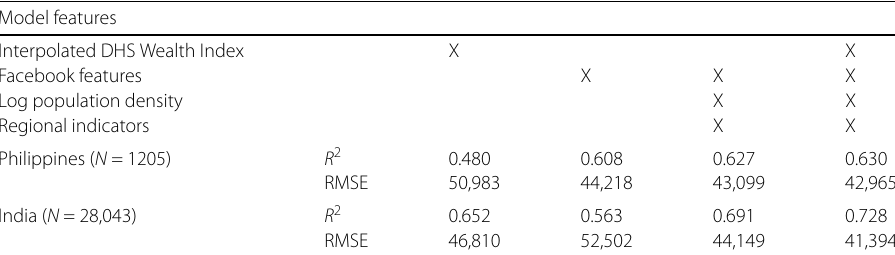
Index for Philippines and India. The table reports cross-validated R 2 and RMSE values Model